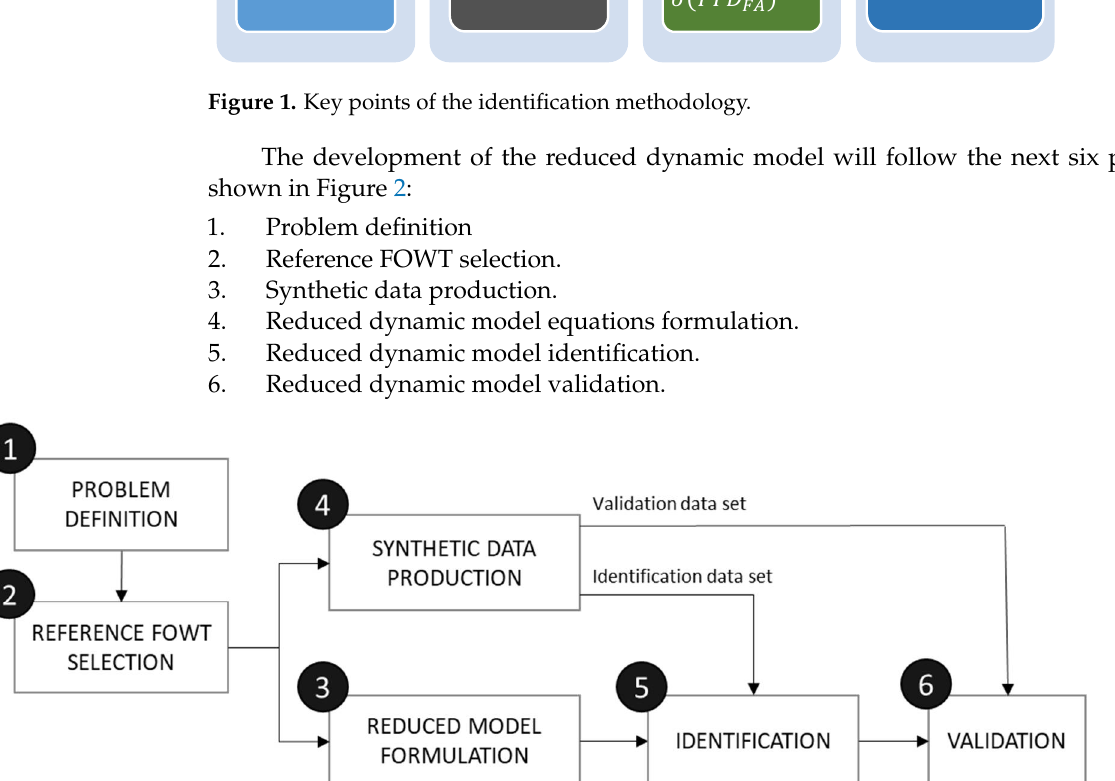
Figure 2. Identification methodology.